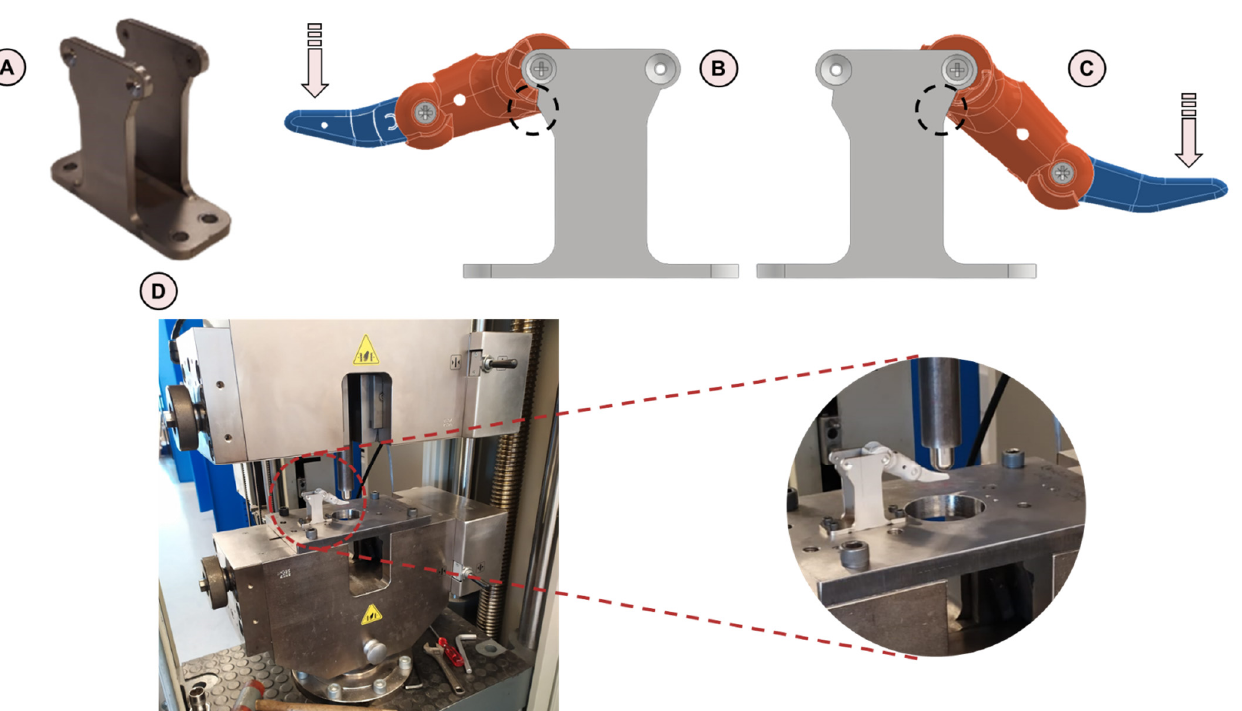
Figure 5. ( A ) Prosthetic finger and thumb support; ( B ) hard-stop inclination with respect to the horizontal plane of the thumb; ( C ) hard-stop inclination with respect to the horizontal plane of the finger; ( D ) Z250 Zwick Roell testing machine with a zoom on the tested specimen.